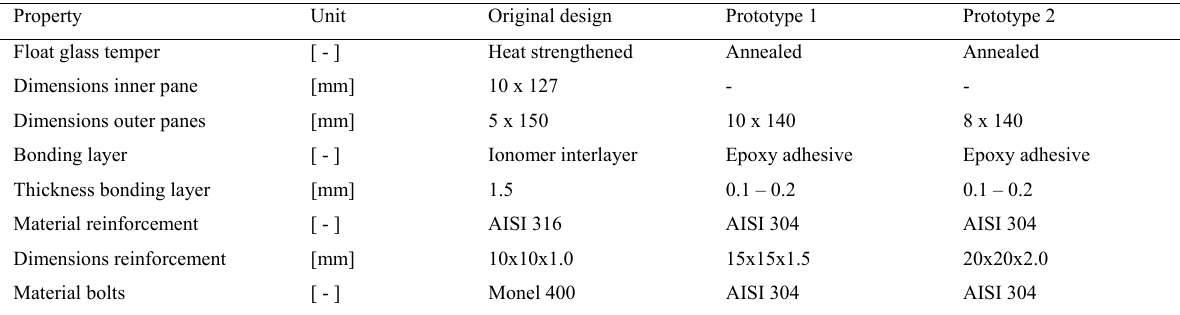
Table 1: Properties of the original design and the two final